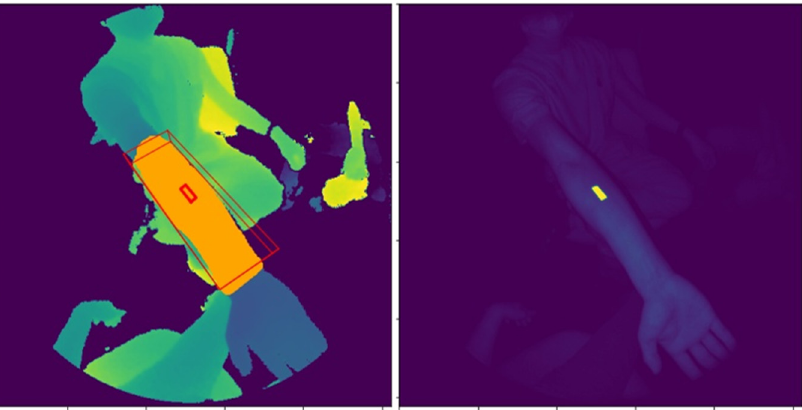
Figure 3. Example of Arm Detection output overlaid onto depth image ( left ), with corresponding NIR image ( right ). Marker and corresponding cuboid region are marked in red, and arm pixels in orange. The retroreflective infrared marker is clearly visible in the NIR image.